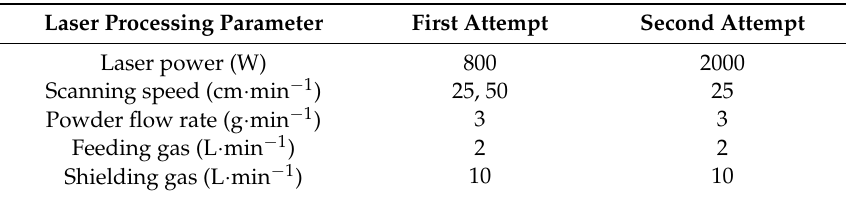
Table 1. Preliminary attempts parameters for laser cladding process.